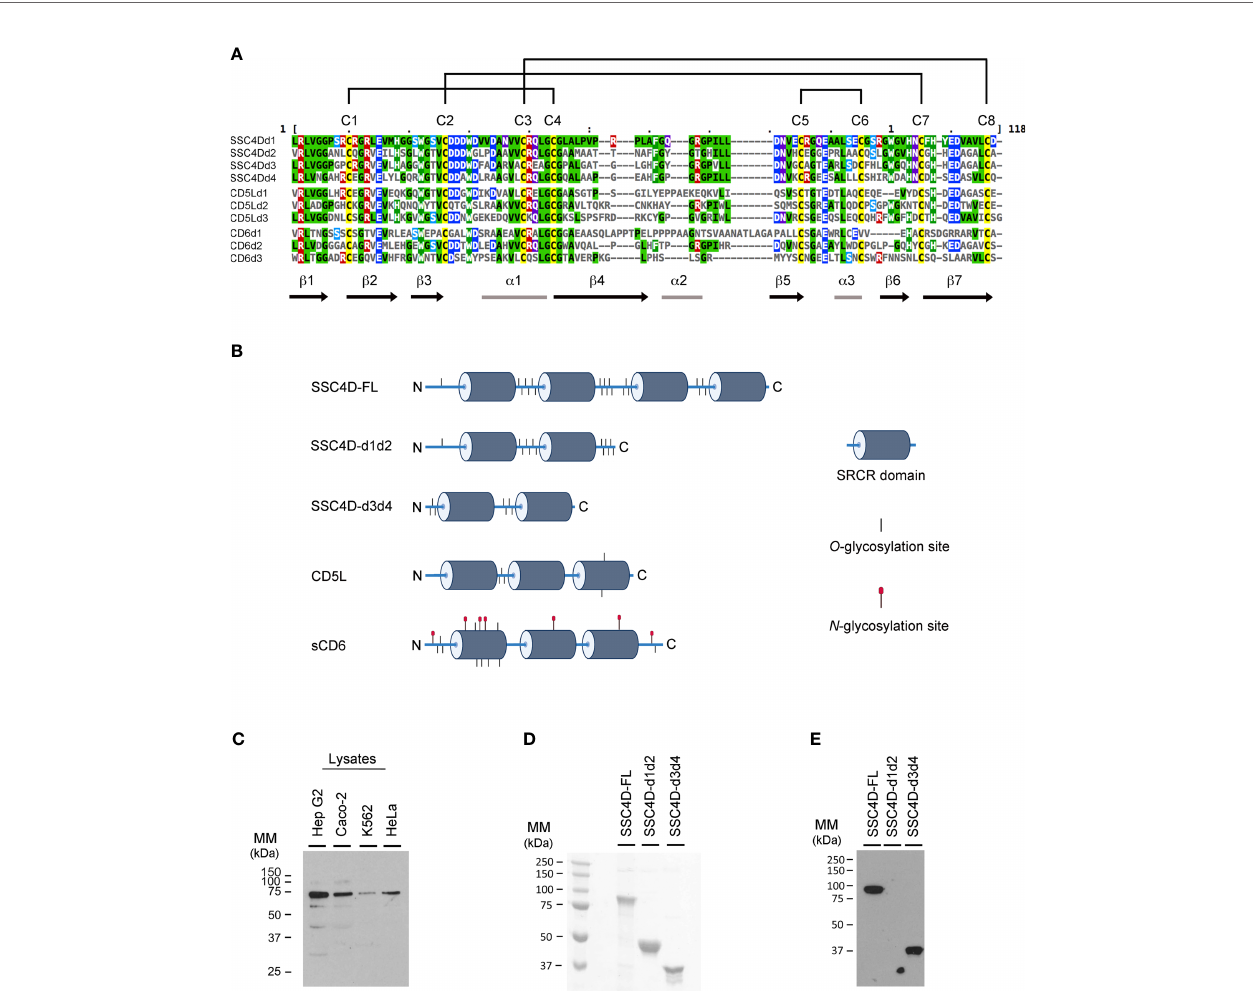
FIGURE 1 | Amino acid sequence and structure of group B scavenger receptor cysteine-rich (SRCR) domains of SSC4D, CD5L, and CD6. (A) SRCR domains are typically ~100 – 110 amino acids in length compacted into a heart-shaped fold, where a six/seven-stranded b sheet cradles a core a 1-helix. Each line represents one SRCR domain of the indicated protein. Amino acid sequences were aligned using Clustal Omega and MView (40). Amino acid side chain color codes for conserved residues: Green/black, aliphatic; Green/white, aromatic; Blue, anionic; Red, cationic; Cyan, polar; Magenta, amide; Yellow, sulfur-containing. Intrachain disul fi de bonds established between conserved cysteine residues are shown on the top by connecting lines. (B) Schematic representation of the protein structures of SSC4D-FL, SSC4D-d1d2, SSC4D-d3d4, CD5L, and extracellular domain of CD6 (sCD6). SRCR domains are represented as dark cylinders. Putative O -linked glycosylation sites are represented as short vertical lines and N -linked glycosylation sites as lines topped with red circles. N and C termini of the proteins are indicated by “ N ” and “ C, ” respectively. Design was created using BioRender.com. (C) SSC4D protein expression detected by western blotting from cell lysates of Hep G2, Caco-2, K562, and HeLa cells. The molecular mass of intracellular SSC4D was calculated as 70.8 kDa. (D) Recombinant SSC4D, SSC4D-d1d2, and SSC4D-d3d4 were run on sodium dodecyl sulfate polyacrylamide gel electrophoresis (SDS-PAGE), and gels were stained with Coomassie blue. The size of recombinant extracellular full-length SSC4D was measured as 90.6 kDa, SSC4D-d1d2 as 45 kDa, and SSC4D-d3d4 as 36 kDa. (E) Recombinant SSC4D, SSC4D- d1d2, and SSC4D-d3d4 were run on SDS-PAGE, transferred to nitrocellulose membranes, and detected by immunoblotting. SSC4D and SSC4D-d3d4 were con fi rmed at the correct sizes, while SSC4D-d1d2 is not detected given that the polyclonal antibodies recognize sequences within domains 3 and